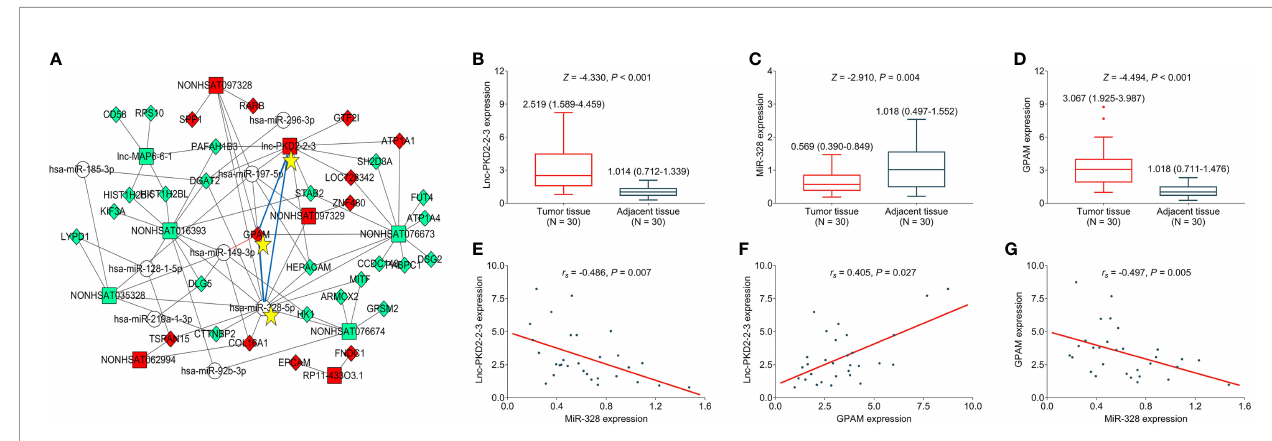
FIGURE 1 | Measurement of lnc-PKD2-2-3, miR-328 and GPAM in CCA patients. Identi fi cation of lnc-PKD2-2-3/miR-328/GPAM network related to CCA pathology (A) . Comparison of lnc-PKD2-2-3 (B) , miR-328 (C) , and GPAM (D) between tumor and adjacent tissues. Correlation between lnc-PKD2-2-3 and miR-328 (E) , between lnc-PKD2-2-3 and GPAM (F) , and between miR-328 and GPAM (G)